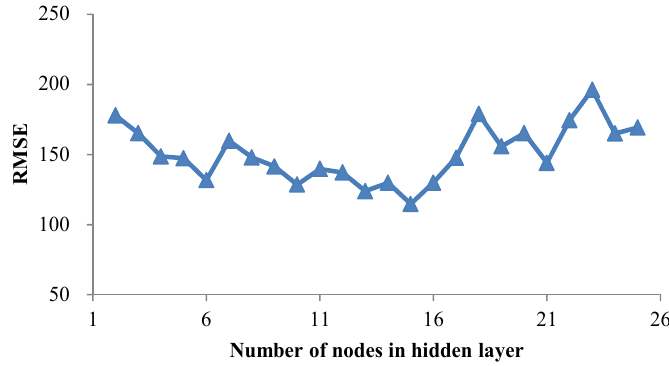
Figure 7. Performance of ANN model with different hidden nodes.